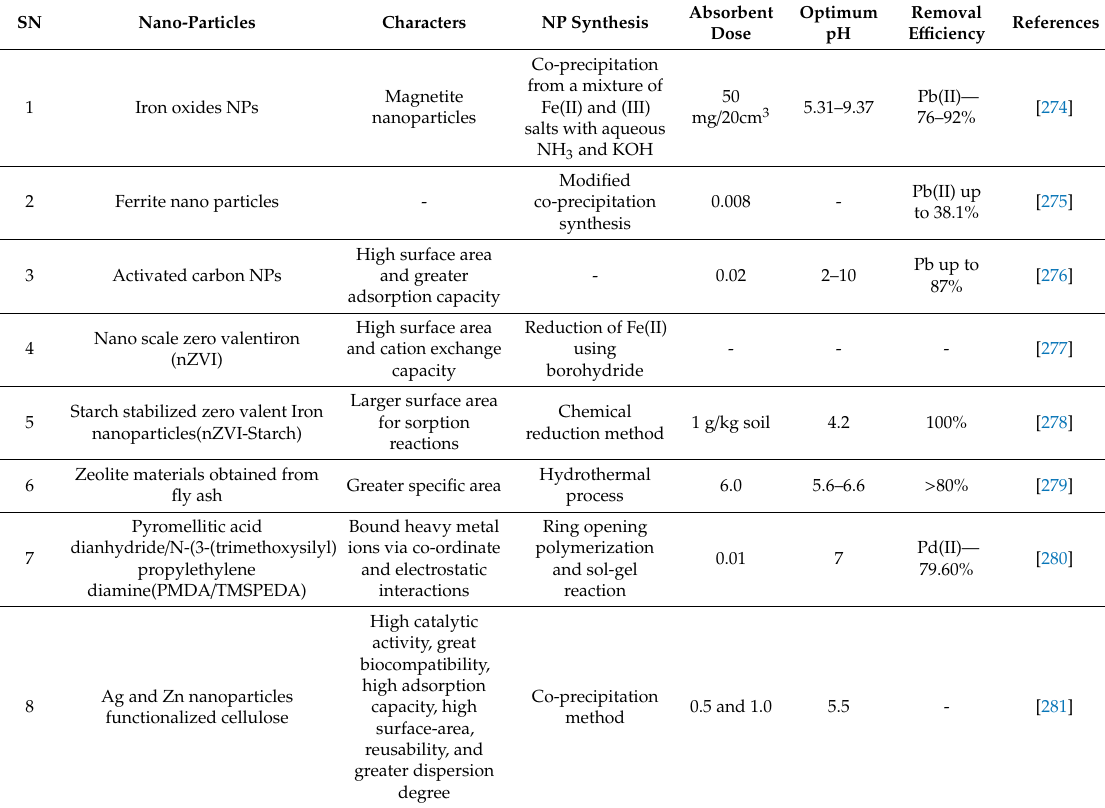
Table 9. Characteristics of nano-particles in Pb removal [18].